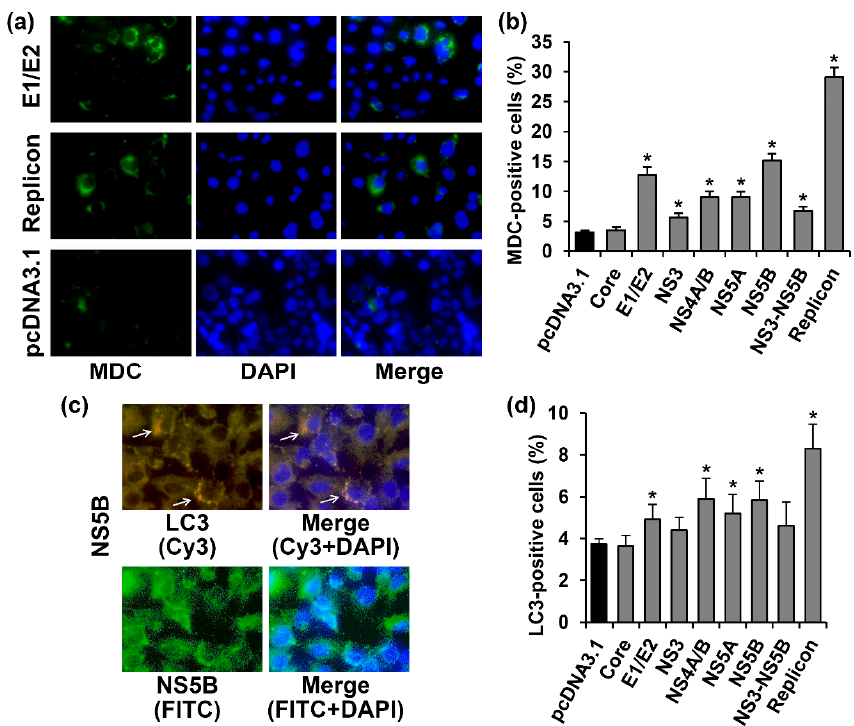
Figure 4. HCV proteins activated autophagy in Huh7.5 cells, as revealed by the enhanced incorporation of monodansylcadaverine into autophagosomes and detection of LC3. ( a ) Huh7.5 cells harboring the HCV replicon, or transfected with the E1/E2-expressing plasmid or the empty pcDNA3.1(+) vector were stained 72 h posttransfection with the monodansylcadaverine (MDC) and with DAPI. Vertical panels from the left to the right are: MDC staining (green), nuclear staining with DAPI (blue), overlay of MDC and DAPI staining; ( b ) Percentages of MDC-positive cells. ( c ) immunofluorescent staining of the activated LC3 and NS5B protein in Huh7.5 cells (400 × magnification). Vertical panels left to right: staining with rabbit anti-LC3 primary and anti-rabbit secondary antibodies conjugated to Cy3 (orange) or primary mouse anti-NS5B antibody and secondary anti-mouse antibodies conjugated to FITC (green), merge with nuclear staining with DAPI (blue) The arrows indicate cells with LC3 punctuate staining; ( d ) Percentages of LC3-positive cells. Values are means ± SEM of eight measurements done in three independent experiments, * p < 0.05 compared to the cells transfected with the empty vector (black